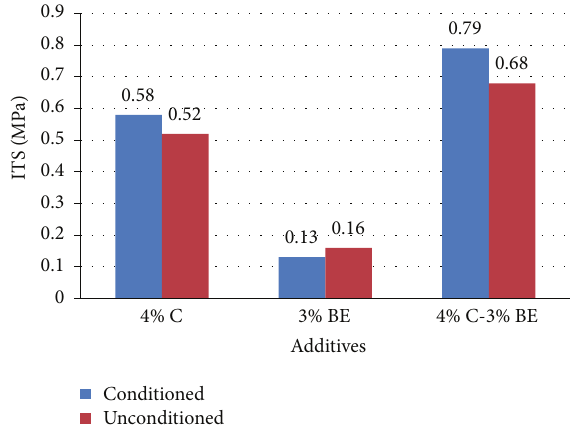
Figure 7: ITS values of conditioned and unconditioned